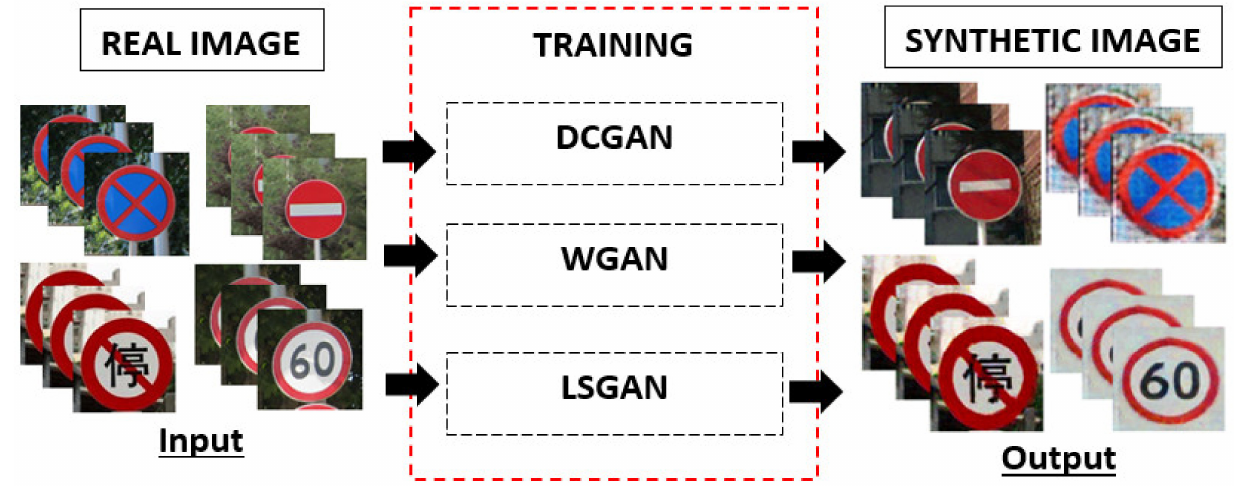
Figure 3. The system architecture. Table 3. Advantages and disadvantages of various